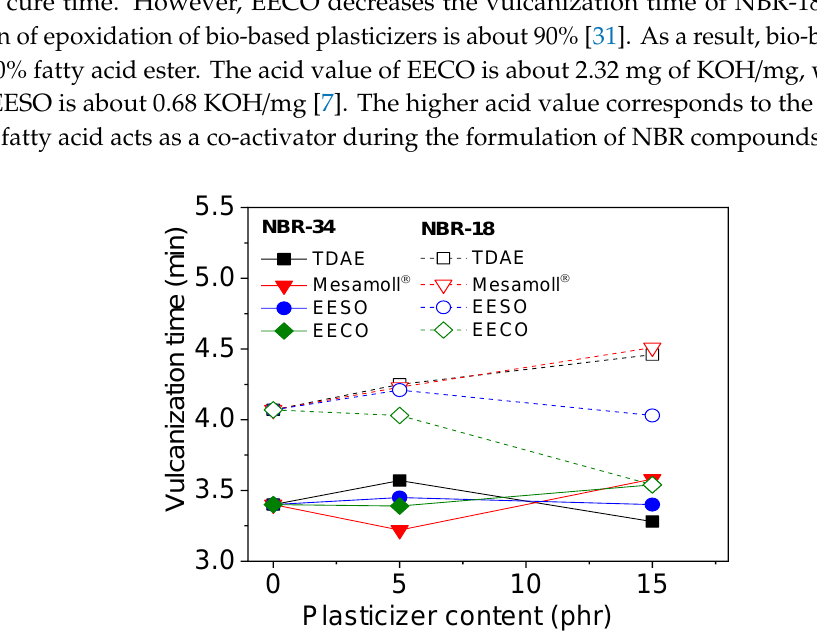
Figure 3. Vulcanization time as a function of plasticizer content for the investigated NBR compounds.